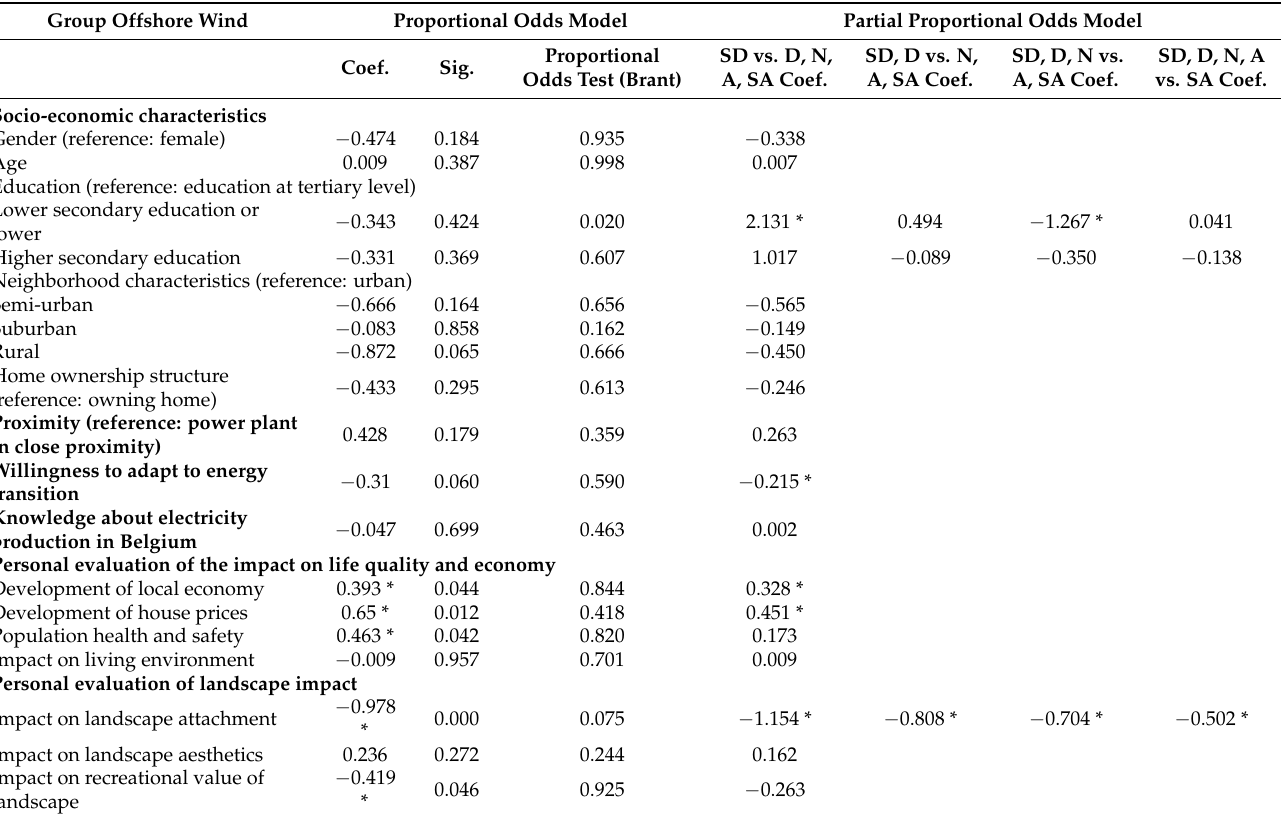
Table A4. Proportional odds model and partial proportional odds model for general attitude towards offshore wind energy. Group Offshore Wind Proportional Odds Model Partial Proportional Odds Model